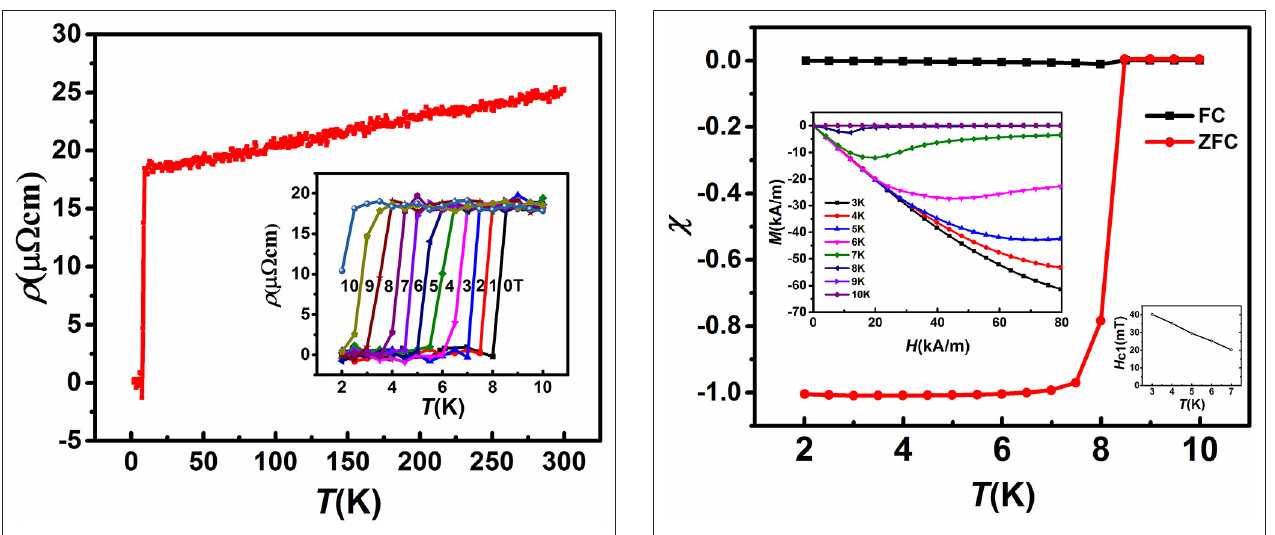
FIGURE 2 | Temperature dependence of electrical resistivity ρ ( T ) in zero field of the Ti 15 Zr 15 Nb 35 Ta 35 HEA. The inset shows the variation of resistivity as a function of temperature under magnetic field ρ ( T ) H up to10T field.